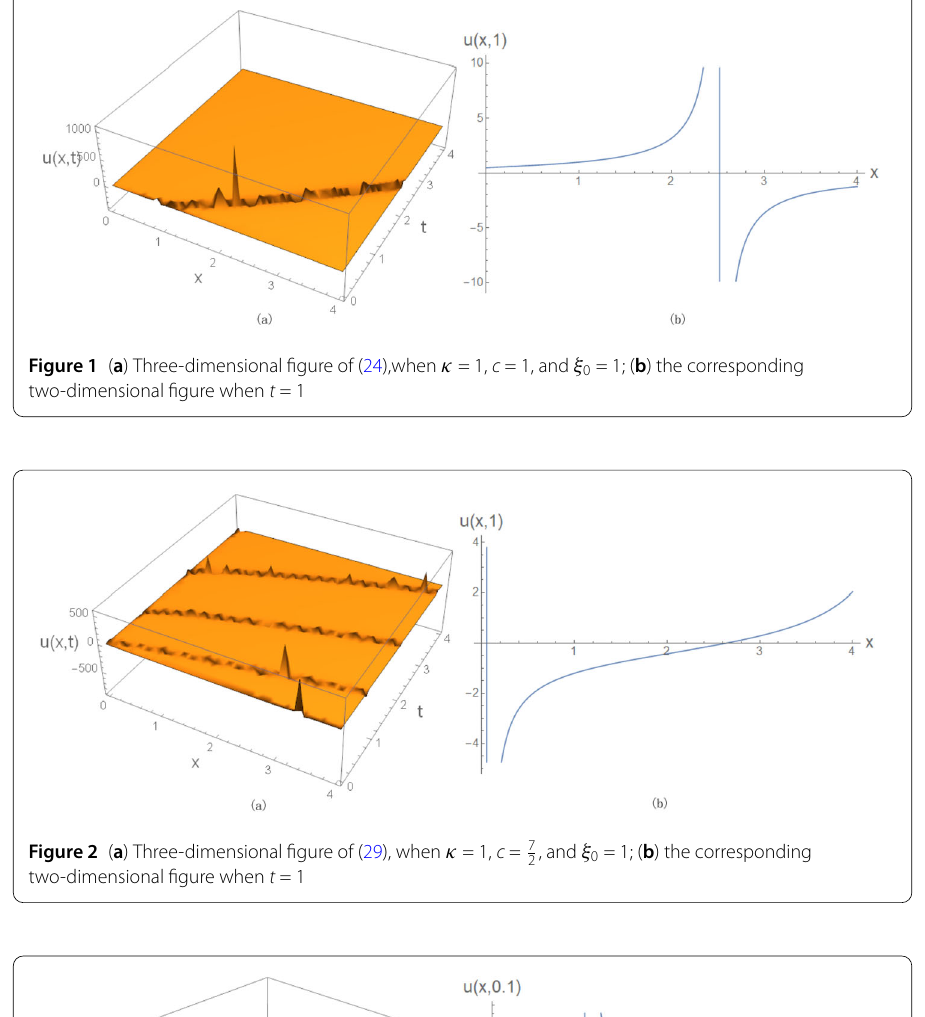
Figure 2 ( a ) Three-dimensional figure of (29), when κ = 1, c = 7 two-dimensional figure when t = 1